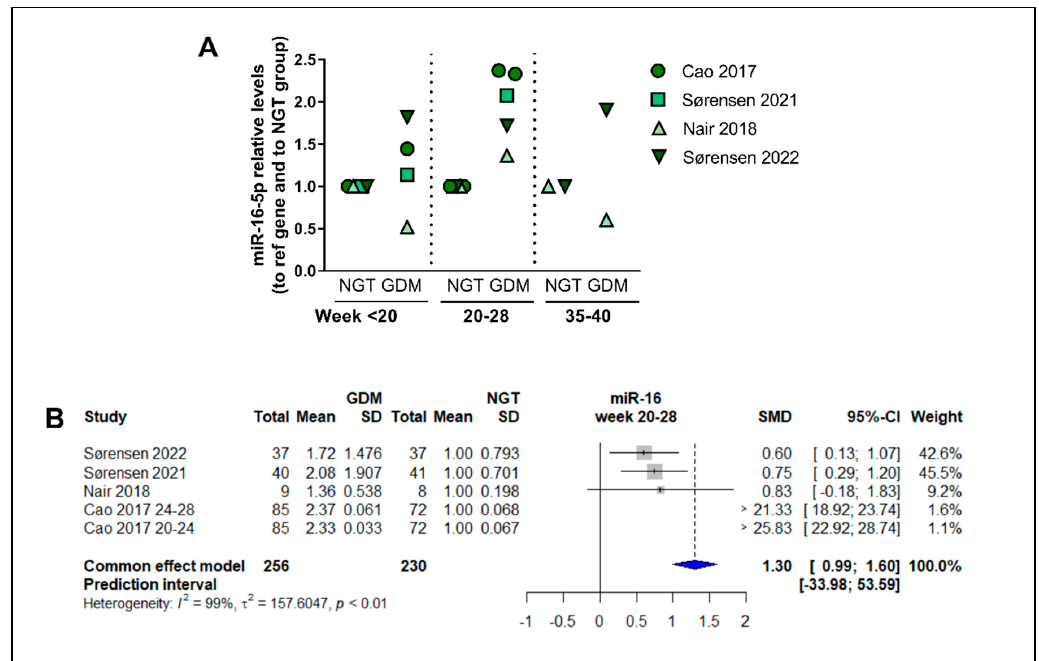
Figure 7. Overall temporal regulation of the circulating levels of miR-16-5p throughout gestation: ( A ) Circulating levels of miR-16-5p at <20 weeks, 20–28 weeks, and 35–40 weeks of gestation, plotted for Cao et al., 2017 [30], Sørensen et al., 2021 [21], Nair et al., 2018 [52], and Sørensen et al., 2022 [20], calculated relative to levels in nondiabetic control women matched for gestational age. ( B ) Main- e ff ects meta-analysis for circulating levels of miR-16-5p at gestational weeks 20–28.